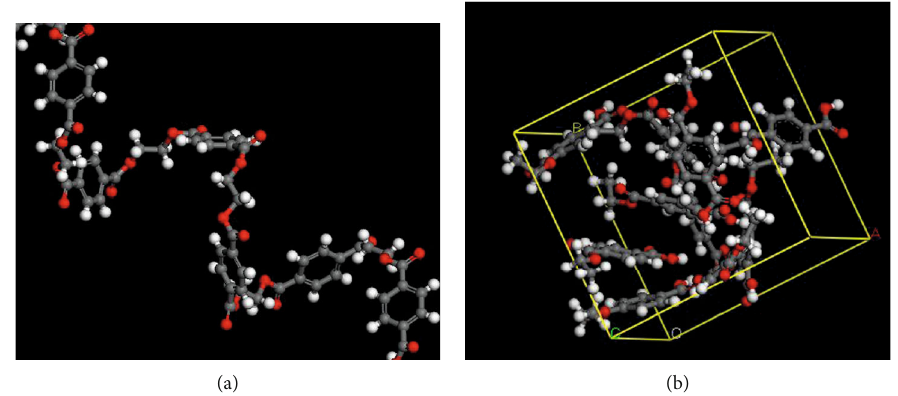
Figure 1: Molecular model of PET before (a) and after construction (b).